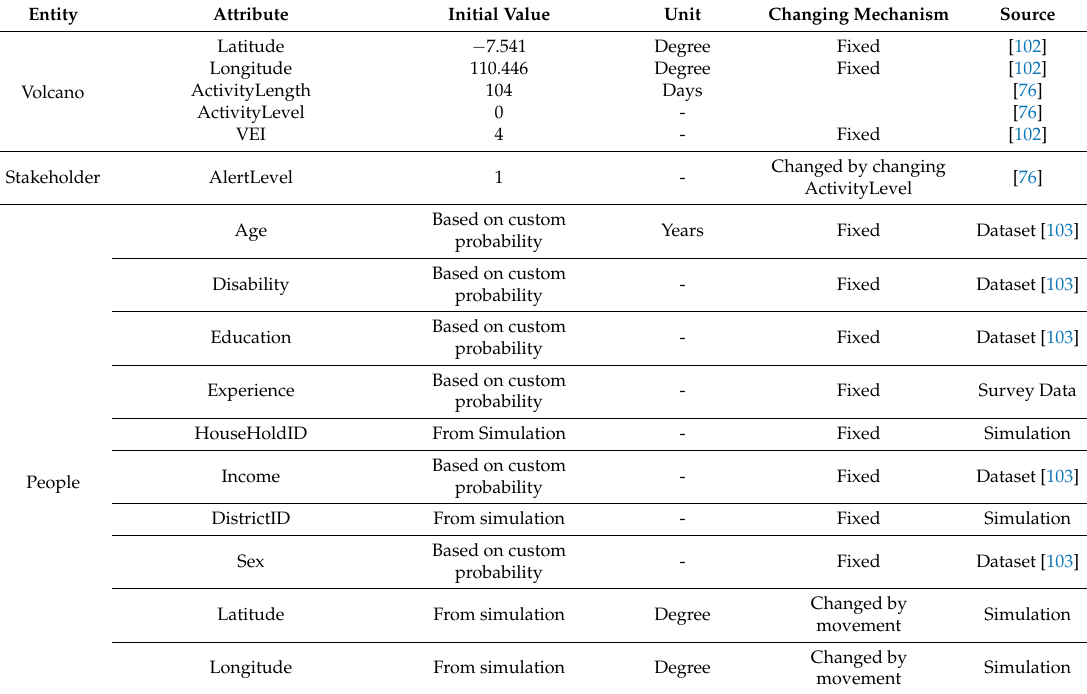
Table 3. Overview of the initialisation of the primary